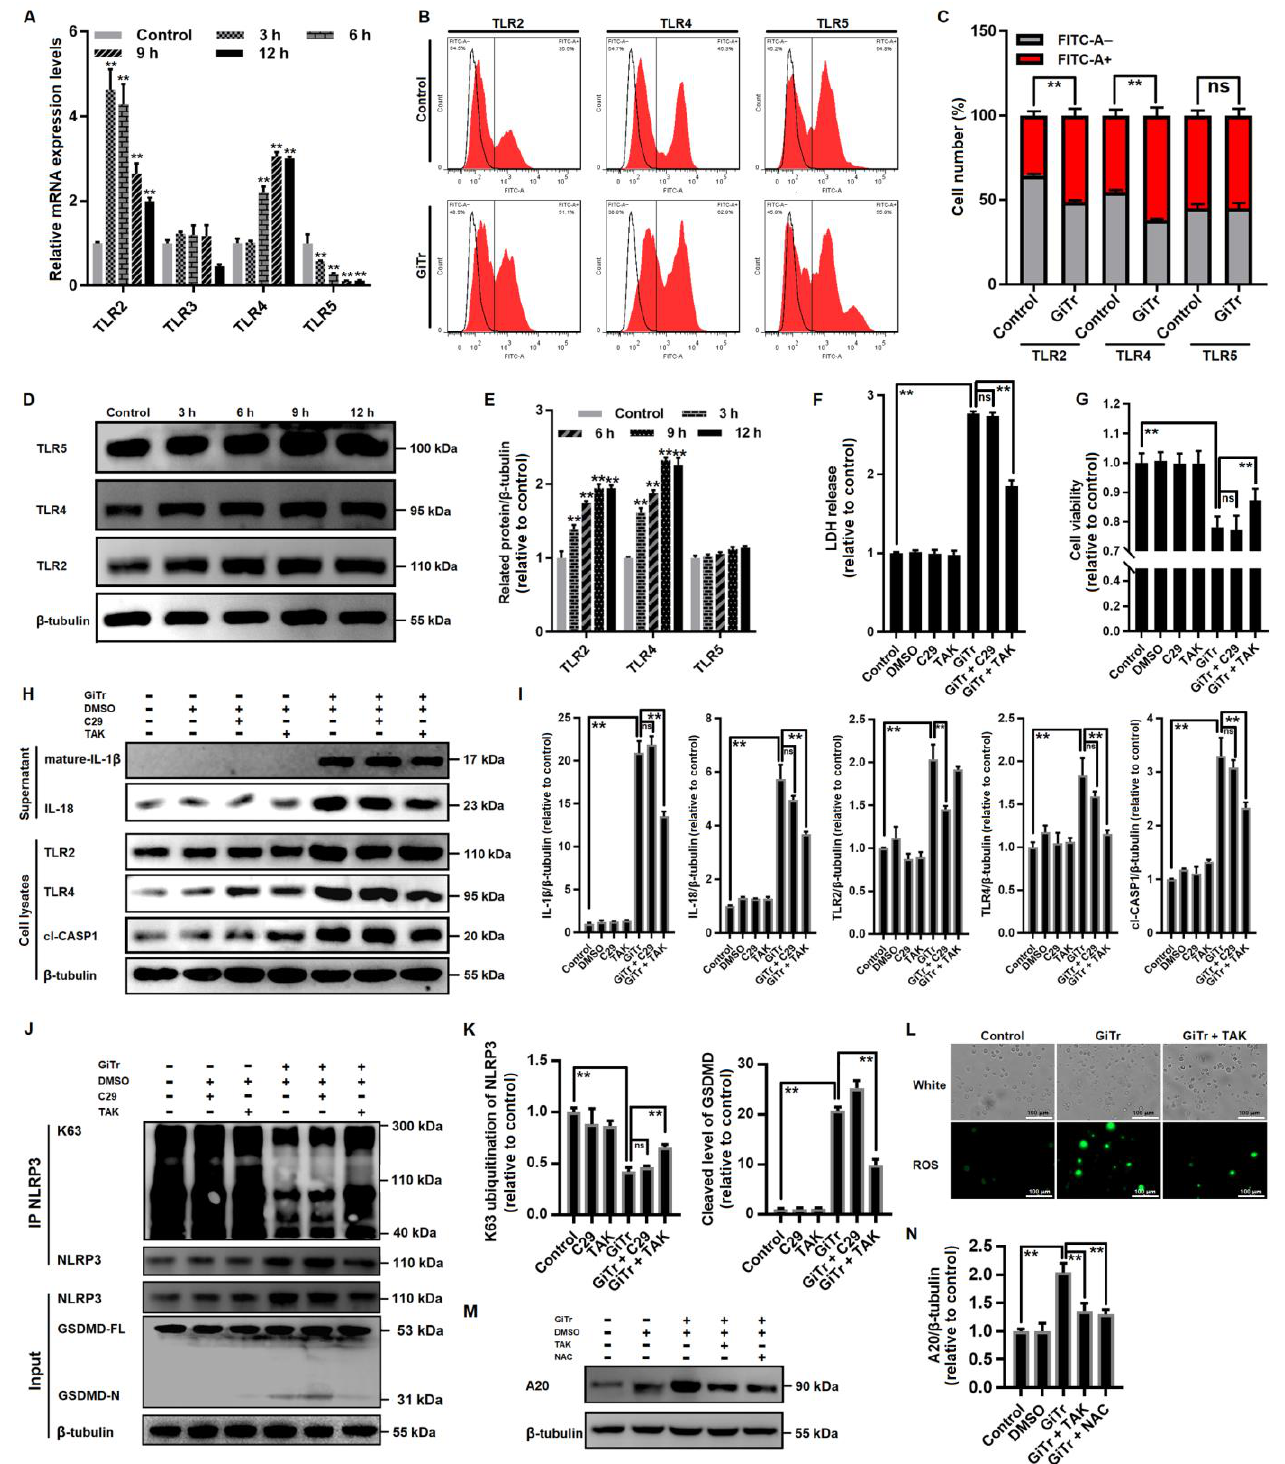
Figure 5. Involvement of TLR4 activation in Giardia -induced macrophage pyroptosis. PMs were treated with trophozoites at a ratio of 10 parasites/cell for the indicated time periods. ( A ) The mRNA levels of TLRs were assessed by qPCR. ( B , C ) The expression of TLRs on PM surfaces were detected by indirect immunofluorescence staining and flow cytometry. ( D , E ) The protein levels of TLR2 and TLR4 were assessed by Western blot analysis. ( F – N ) PMs were pretreated with 20 μM C29, 10 μM TAK, or 10 μM NAC for 2 h, and then stimulated with trophozoites for 12 h. ( F , G ) The cell viability and LDH release were detected. ( H , I ) The effects of C29 or TAK pretreatment on Giardia -induced CASP1 activation and IL-1β and IL-18 secretion were assessed by Western blotting. ( J , K ) The effects of C29 or TAK pretreatment on NLRP3 deubiquitination and GSDMD cleavage induced by Giardia were assessed by co-IP and western blotting. ( L ) Upon trophozoite